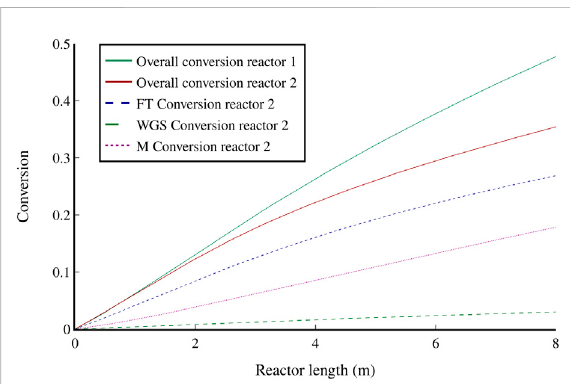
FIGURE 6 The overall conversion of CO in both FT reactors